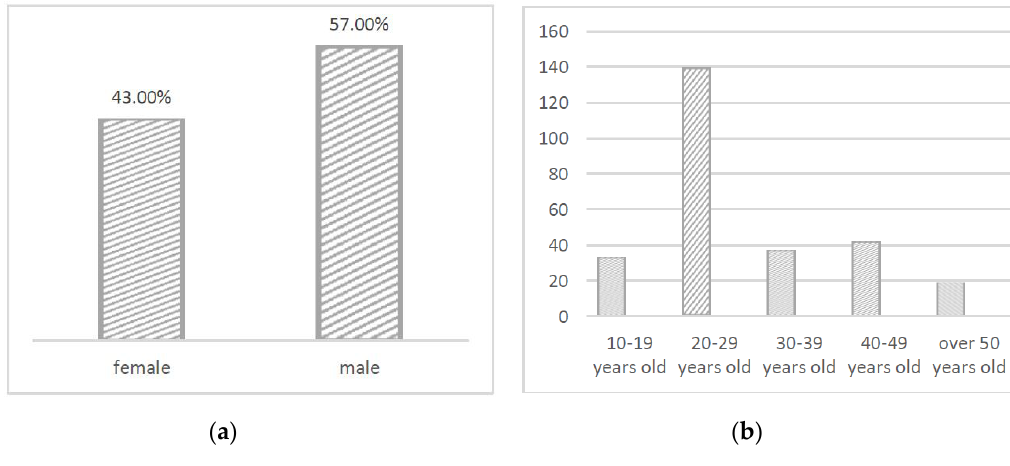
Figure 5. Visitor distribution. ( a ) Gender ratio ; ( b ) Age ratio.